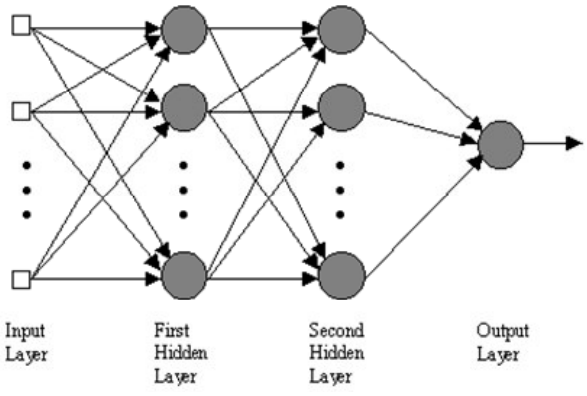
Fig. (4). Artificial Neural Network Model Diagram Fig. 4. Artificial neural network model